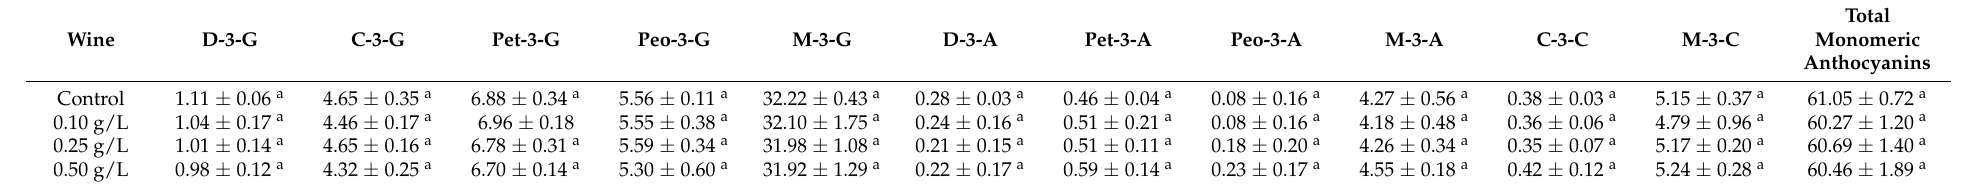
Table 5. Monomeric anthocyanin profile in mg/L of red wines after applying different doses of ADSI cork powder (0.10, 0.25, and 0.50